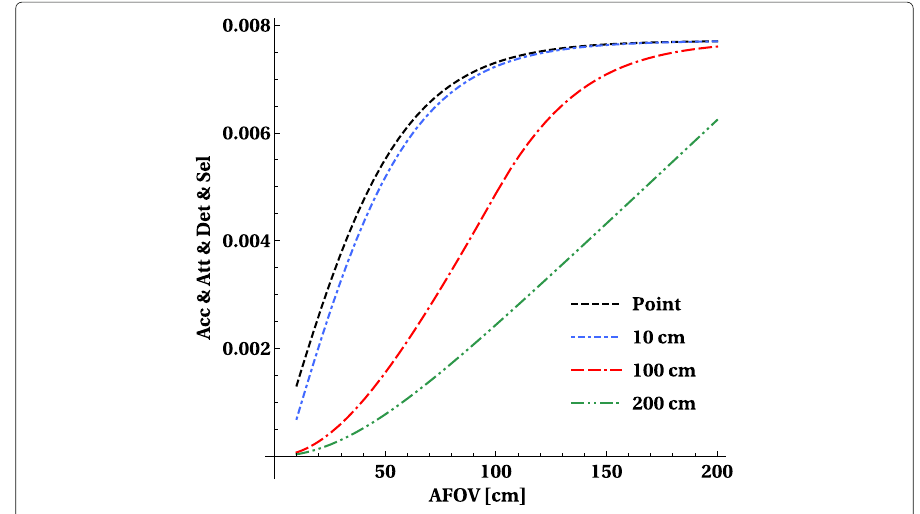
Fig. 6 Sensitivity for detection and selection of image forming events for a point-like, 10-cm-long, 100-cm-long and 200-cm-long central line source taking into account the attenuation caused by a 20-cm phantom and the detection efficiency of a 20-mm-thick LYSO detector. The y -axis displays fraction with maximum value equal to